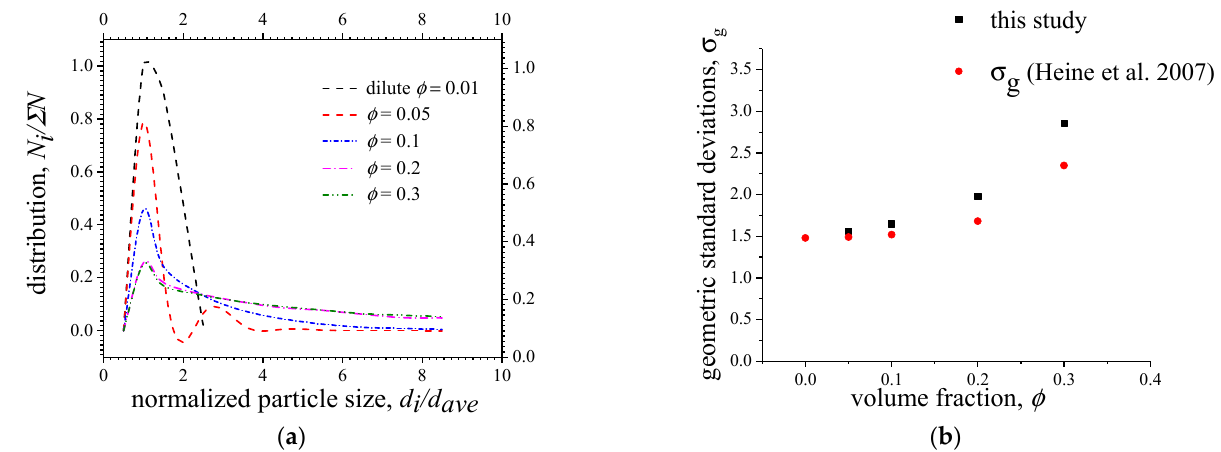
Figure 7. ( a ) Normalized particle size distributions; ( b ) geometric standard deviations with different volume fractions.